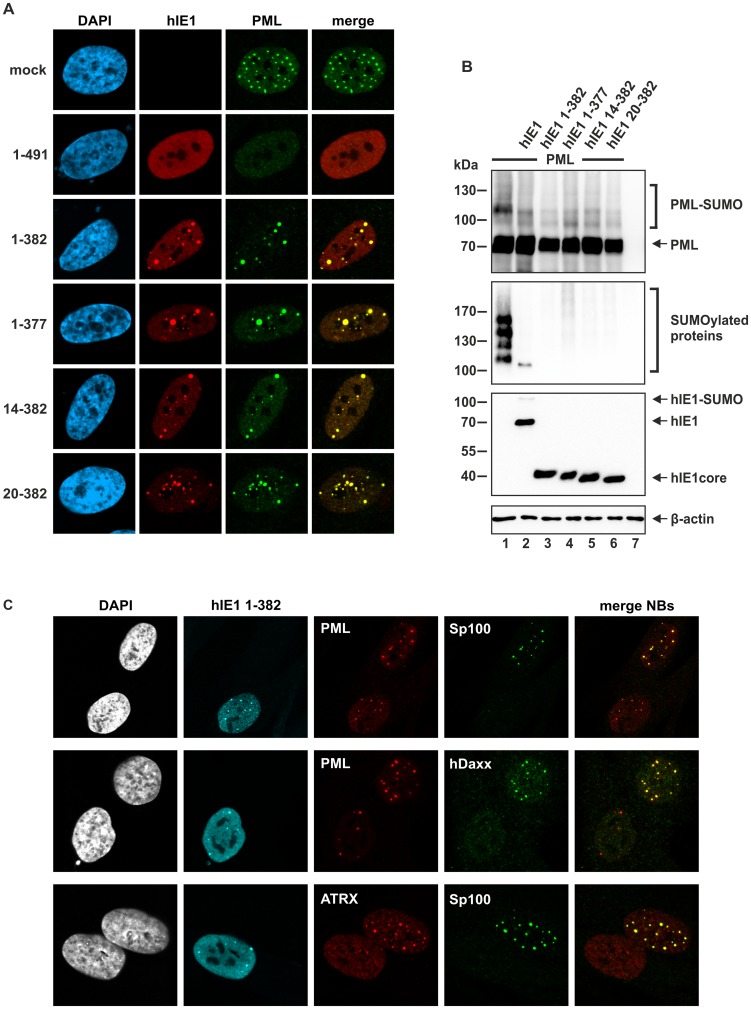
Effect of IE1CORE on the integrity of PML-NBs and the SUMOylation of PML.(A) Dispersal of PML requires the IE1IDRc. HFF cells were transiently transfected with expression plasmids encoding FLAG-tagged full-length hIE1(1–491) or truncated hIE1 variants followed by immunodetection of hIE1 proteins using an anti-FLAG antibody and of endogenous PML. (B) DeSUMOylation of PML by IE1CORE. HEK293T cells were cotransfected with expression plasmids encoding FLAG-PML (isoform VI), FLAG-hIE1 variants as indicated and Myc-SUMO3. PML (upper panel), SUMOylated proteins (second panel), IE1 (third panel) and β-actin (lower panel) were detected by Western blot analysis. (C) Release of Sp100, hDaxx and ATRX from PML foci by IE1CORE. The hIE1CORE(1–382) was stably expressed in HFFs followed by immunodetection of hIE1, PML, Sp100, hDaxx or ATRX by triple staining as indicated.